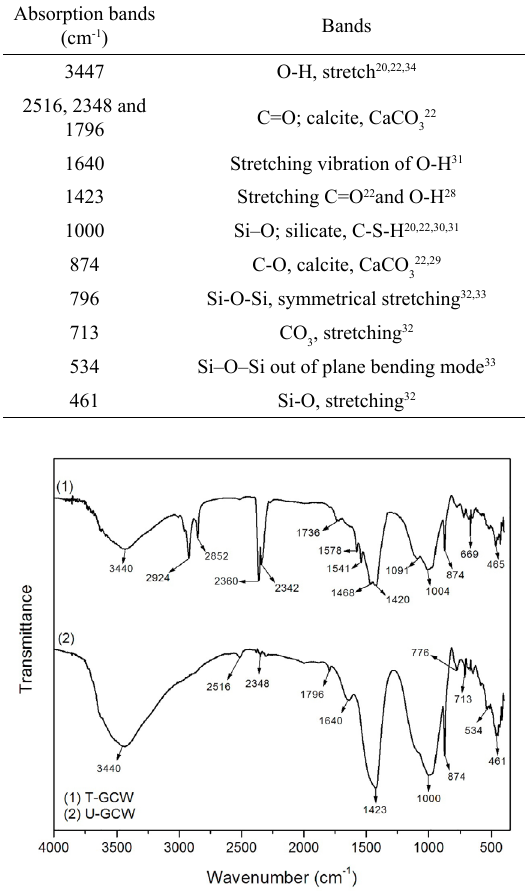
Figure 2. Overlay of the FT-IR spectra of T-GCW and U-GCW.